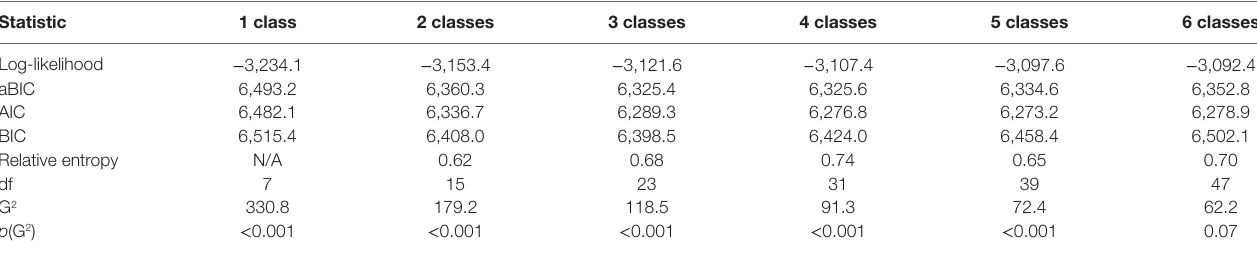
TaBle 5 | Model fit statistics for each of the fitted latent class analysis models.